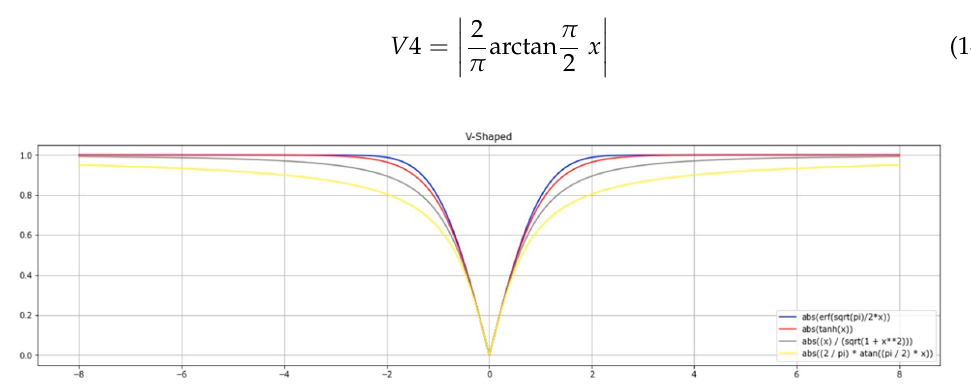
Figure 5. V-shaped transfer function ( V 1–V4).